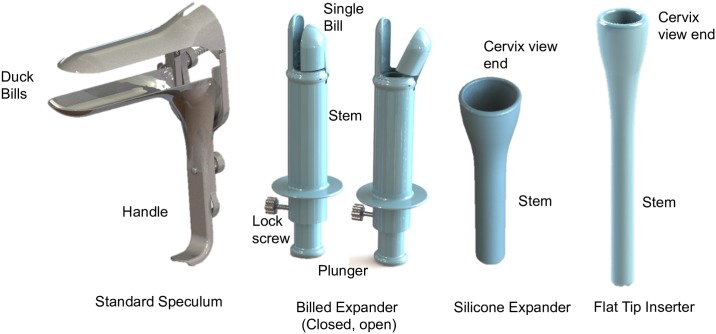
CAD designs of standard speculum (from GrabCAD) and vaginal inserter/expander prototypes.